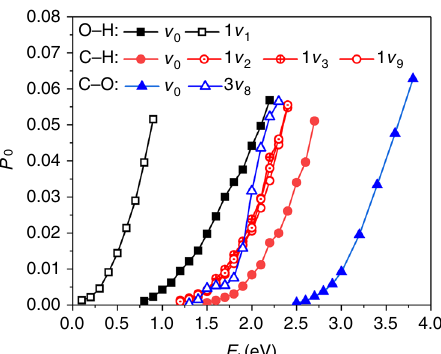
Fig. 4 Branching ratios. C – O/C – H bond dissociation ratio as a function of total energy with respect to the potential energy of free CH 3 OH molecule plus its zero-point energy, varying with the incremental excitation of the C – O stretching mode ( v 8